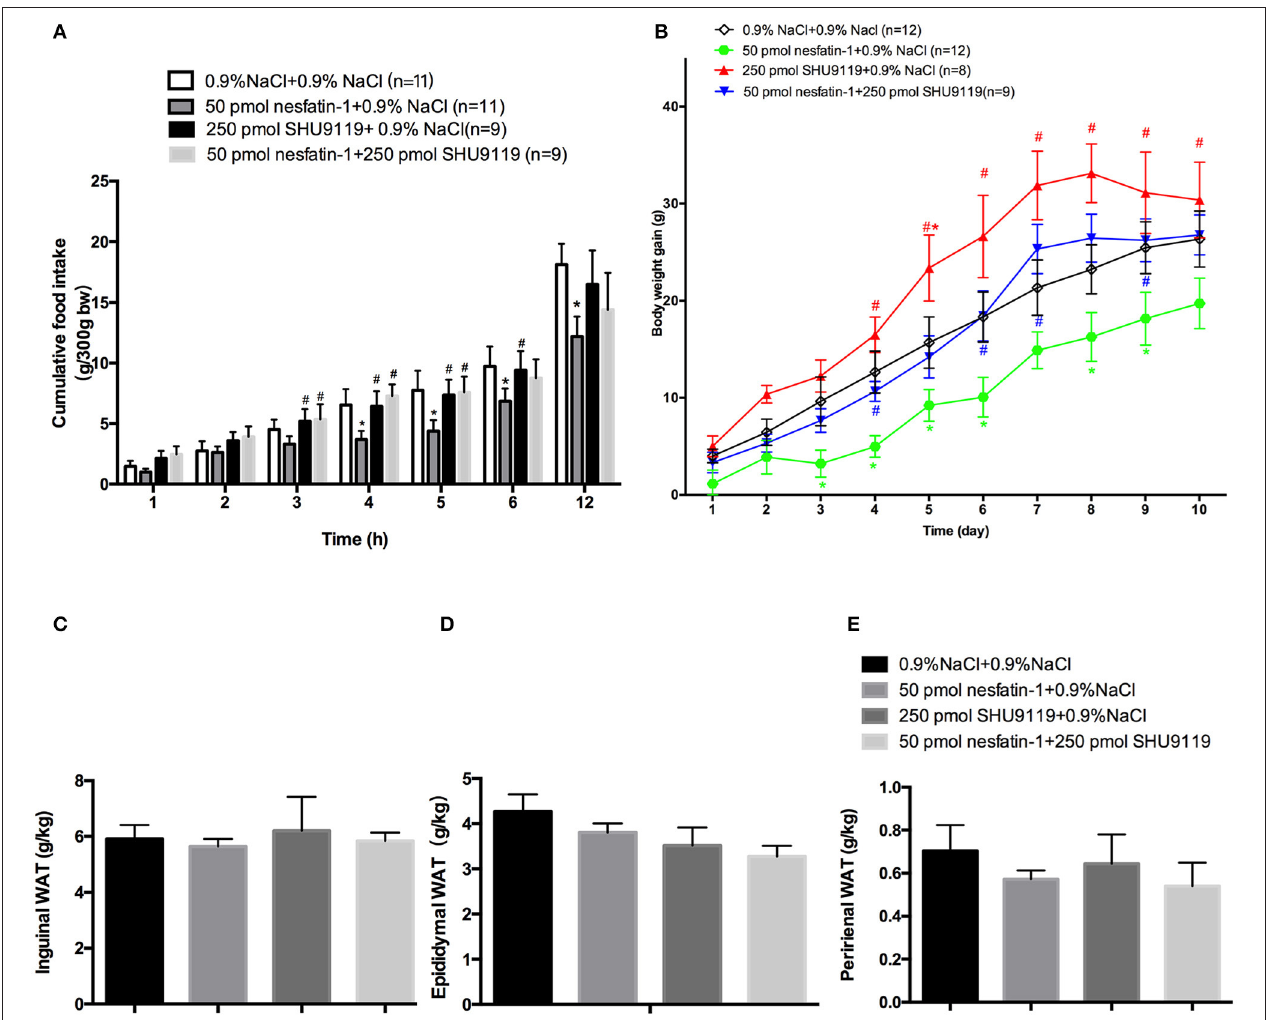
FIGURE 4 | Effects of SHU9119 on the feeding effects of nesfatin-1. (A) Effects of SHU9119 on nesfatin-1-induced nocturnal anorexia. Four groups of rats received microinjections (0.5 µ l) into the LPBN at the onset of the dark cycle and cumulative food intake was recorded. (B) Effects of SHU9119 on nesfatin-1-induced body weight changes. Nesfatin-1-treated animals gained less weight than the other three groups. Rats were sacrificed after 10 days of central injections. (C–E) Unilateral WAT from epididymal, inguinal, and perirenal regions was weighed. Data represent the mean ± SEM of 9-11 rats/group. * P < 0.05 vs. saline vehicle-injected controls; # P < 0.05 vs. nesfatin-1